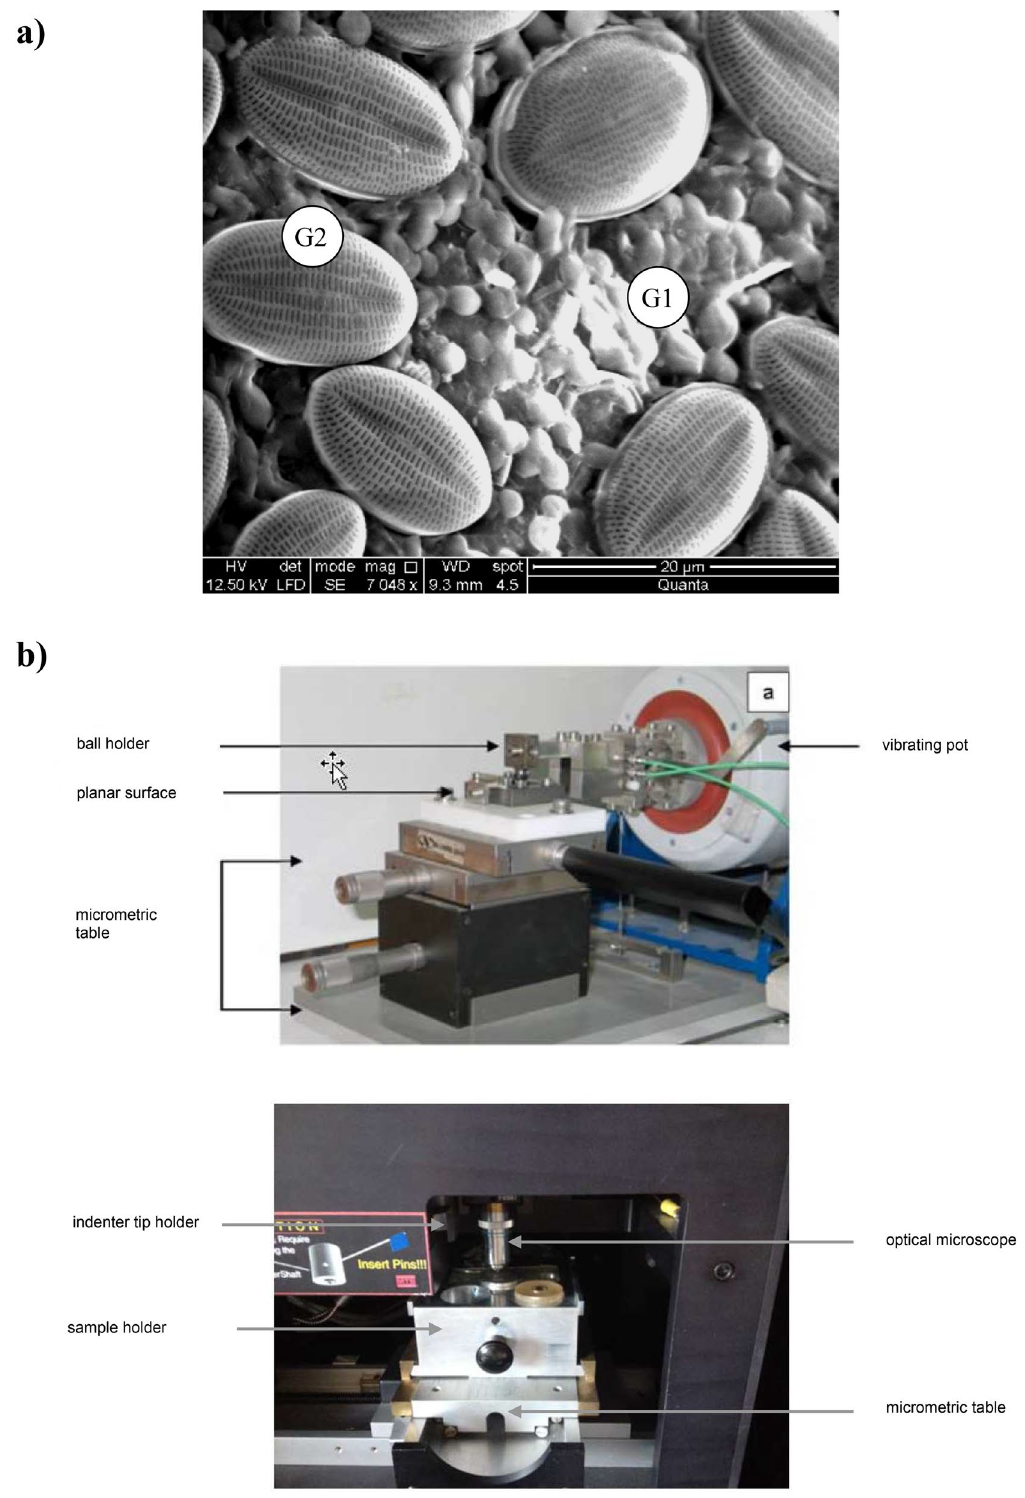
Figure 6. ( a ) Image showing the two first superimposed layers (bacterial G1 and bacteria + small diatoms in G2) during colonization process, ( b ) experimental alternative tribometer sphere/plane under ambient atmosphere (upper panel, conception and realisation GTSI team), and XP nanoindenter (lower panel). The images in this figure were taken by the